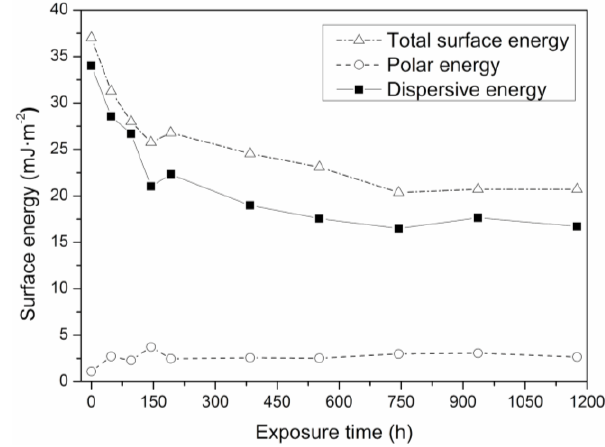
𝑠𝑝 ) and dispersive contributions (𝛾 𝑠𝑑 ) of